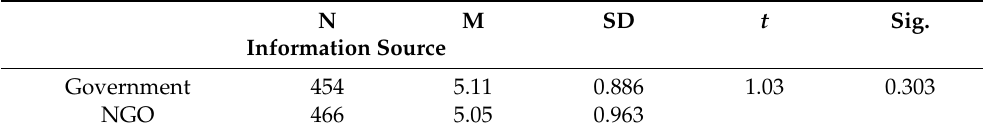
Table 4. Independent t -test for information source.